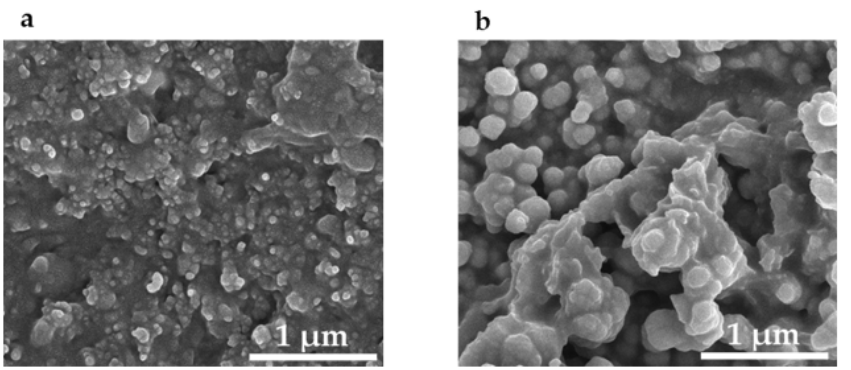
Figure 5. Schematic flowchart of the transfer process. Portions enlarged for clarity.